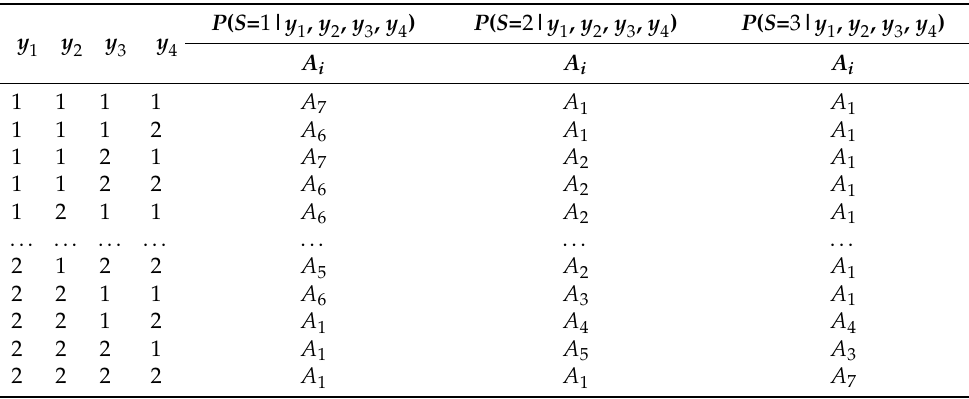
Table 3. FCPT of leaf node casualties in the